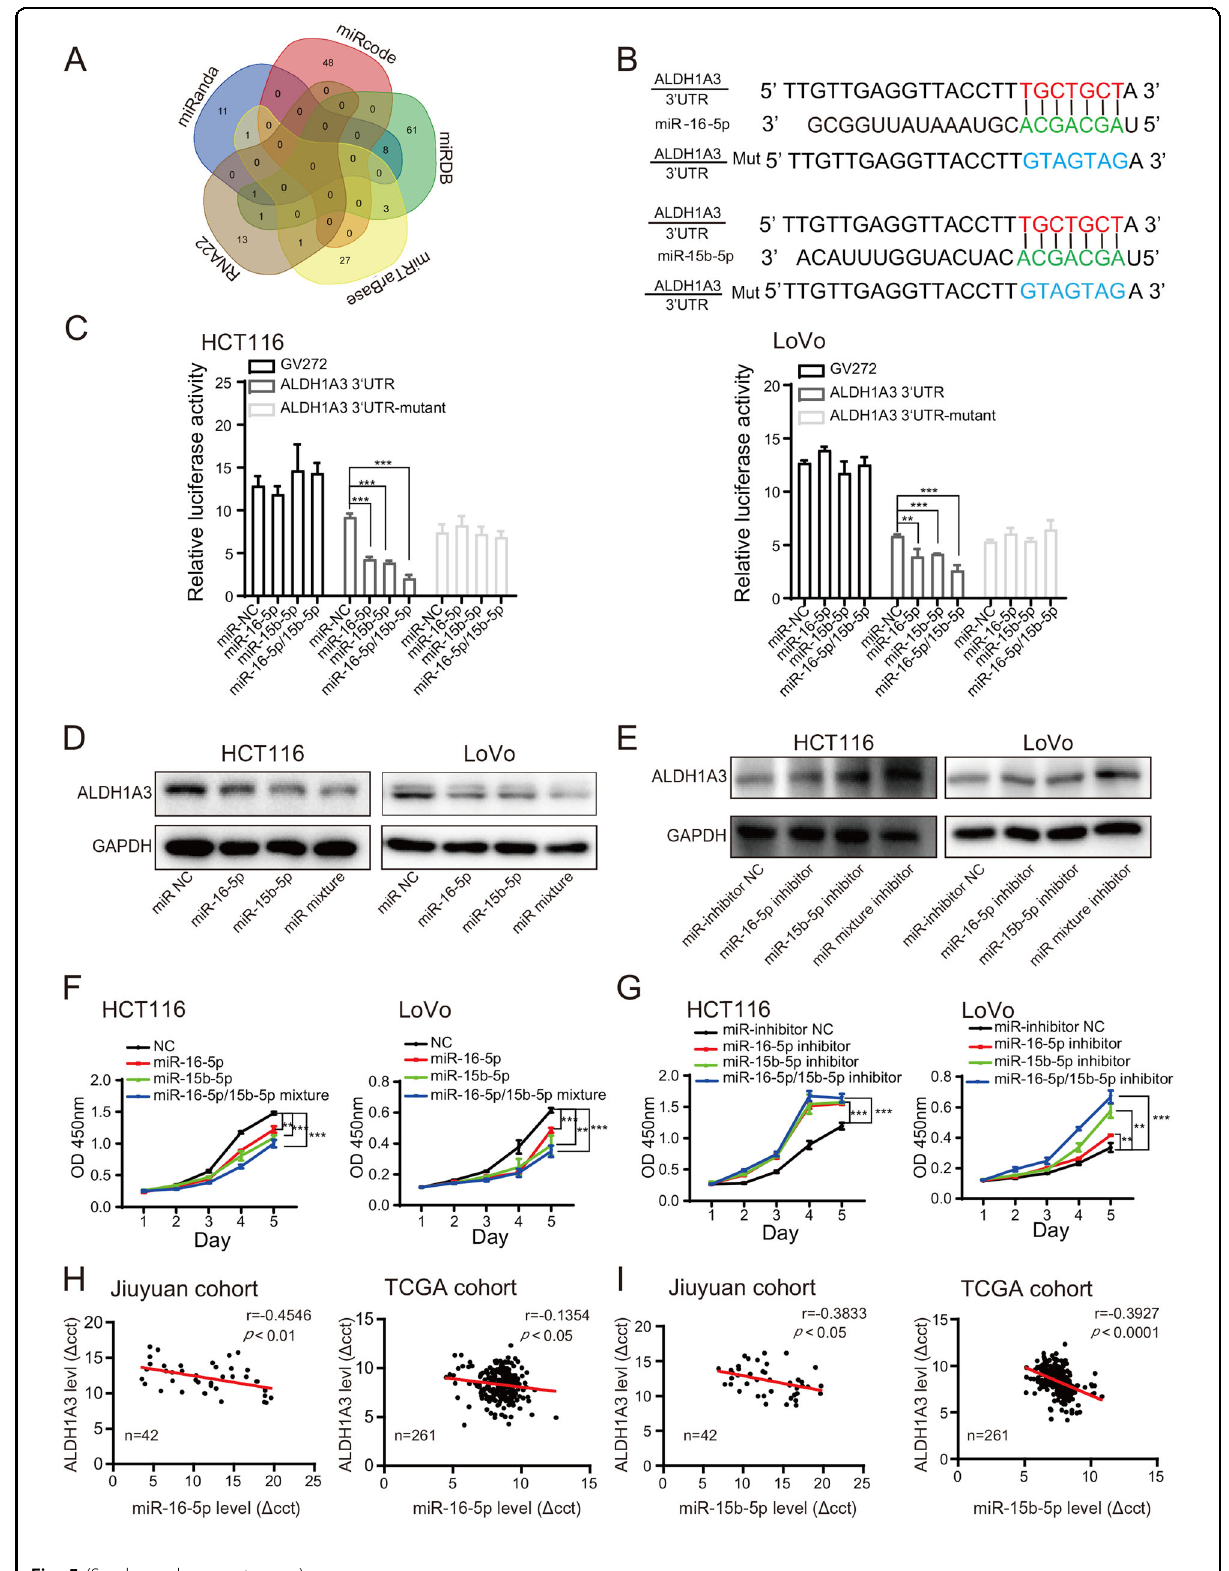
Fig. 5 (See legend on next